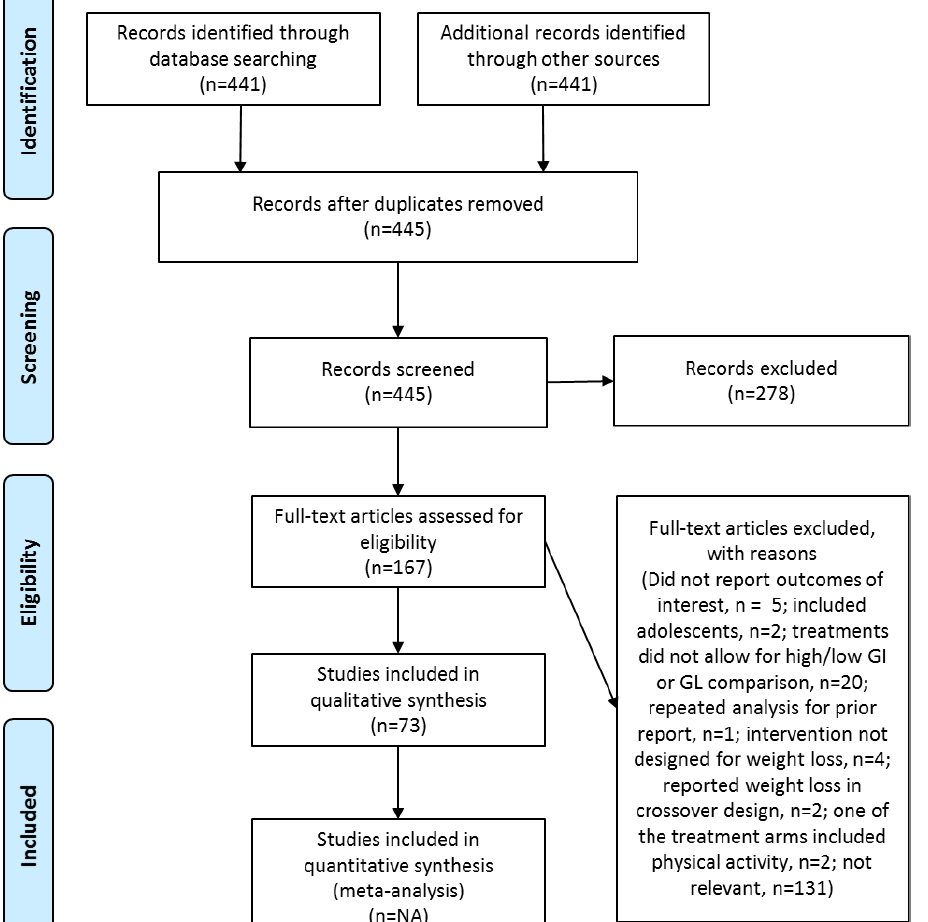
Figure 1. PRISMA Flow Diagram illustrating study selection.